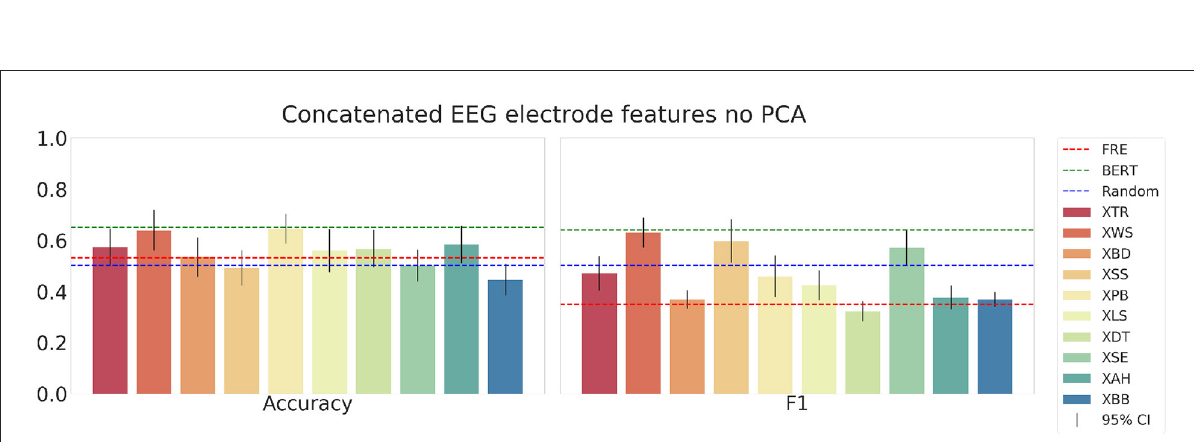
FIGURE11 The mean accuracy (left) , mean F1-score (right) with corresponding 95% confidence intervals and textual baselines are plotted for each subject in the held-out test dataset using the concatenated EEG electrode features without PCA